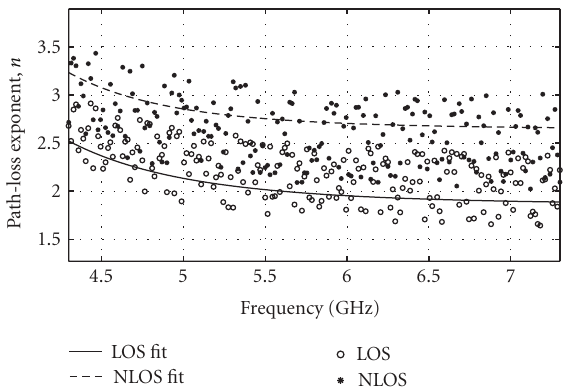
Figure 2: Illustration of the measurement locations in a typical o ffi ce room.